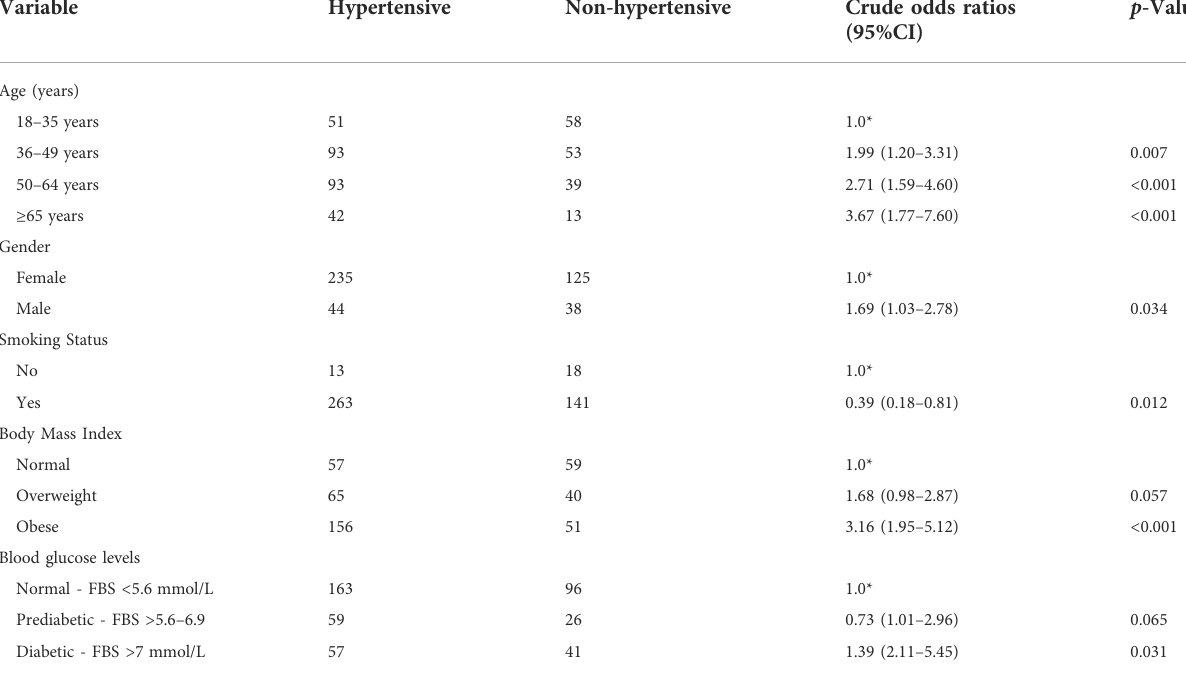
TABLE 2 Associations of age, gender, BMI, smoking status, and blood glucose levels with the risk of developing HTN.